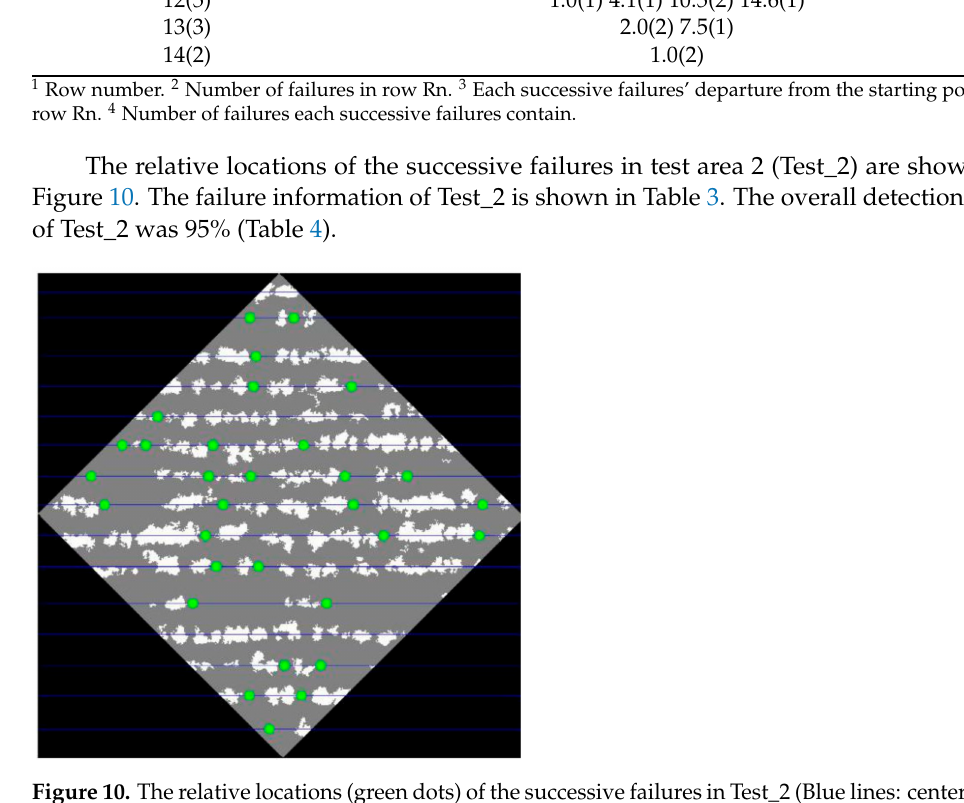
Figure 10. The relative locations (green dots) of the successive failures in Test_2 (Blue lines: centerlines of seedling